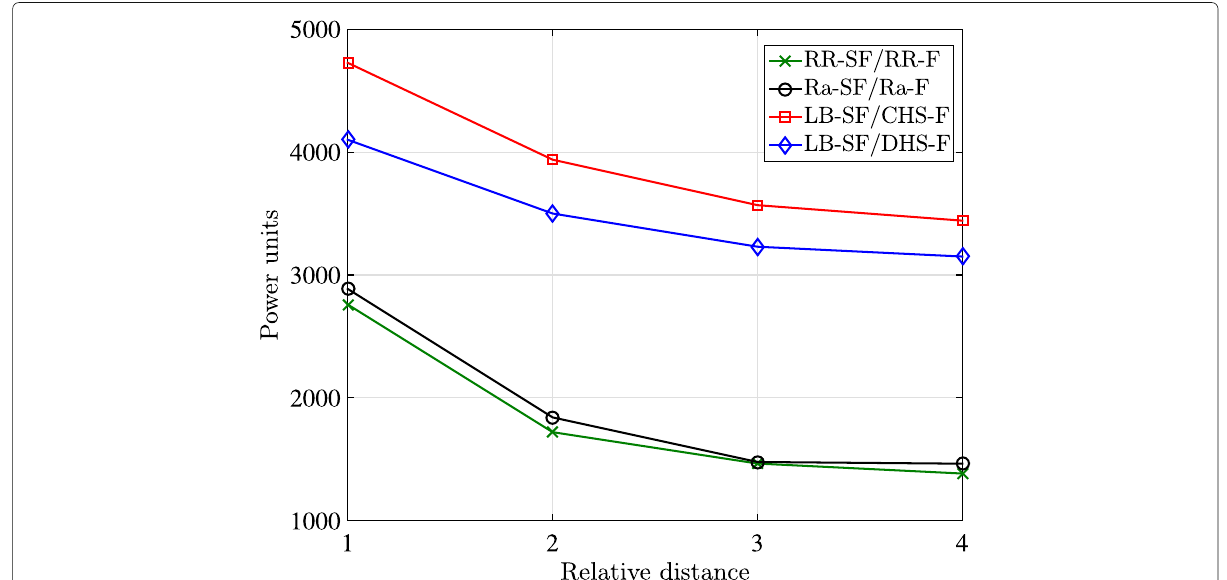
Fig. 9 Sum of expected harvested powers by all users vs distance to the BS. Sum of the expected harvested powers by all users (in power units) as a function of the distance to the BS